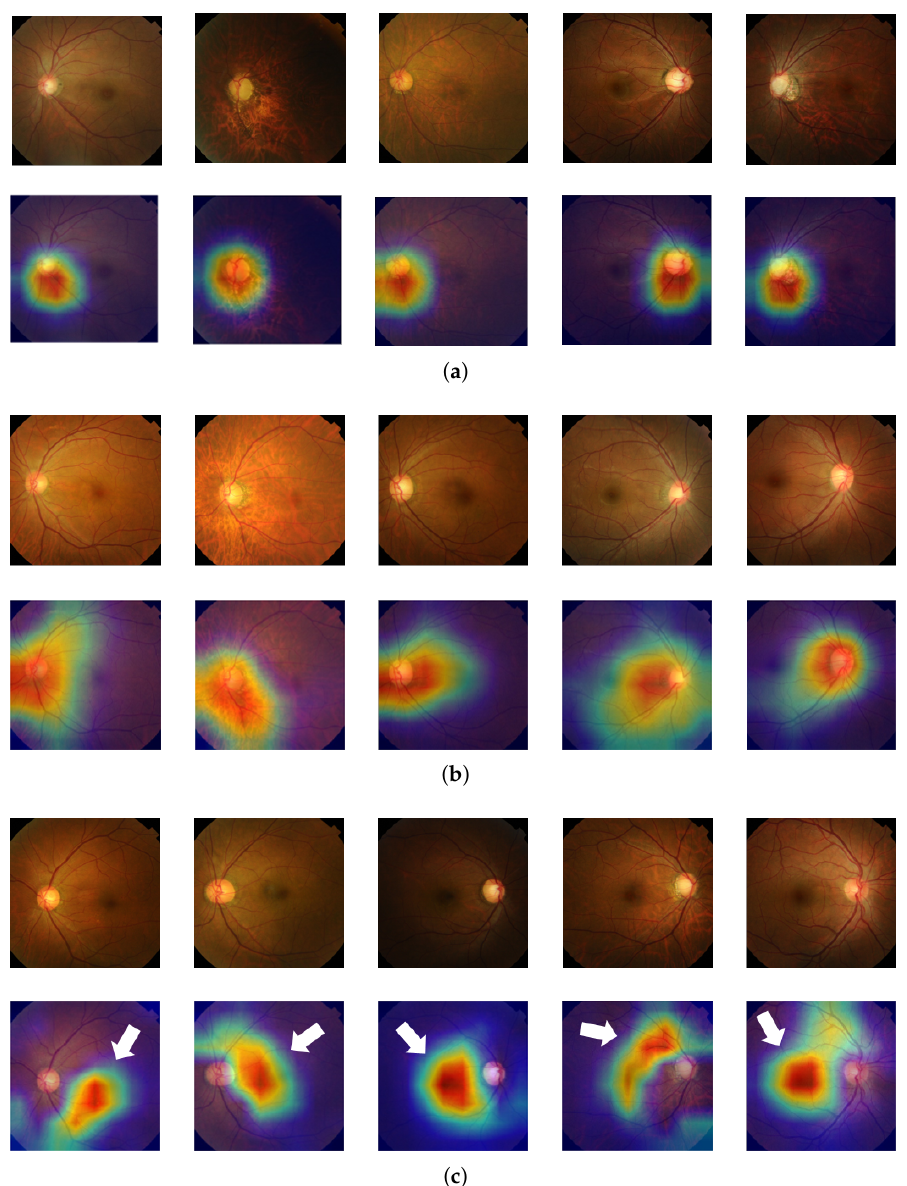
Figure 7. Segmented highlights obtained for glaucomatous areas. ( a ) True positive localization examples. ( b ) True negative localization examples. ( c ) Abnormal localization